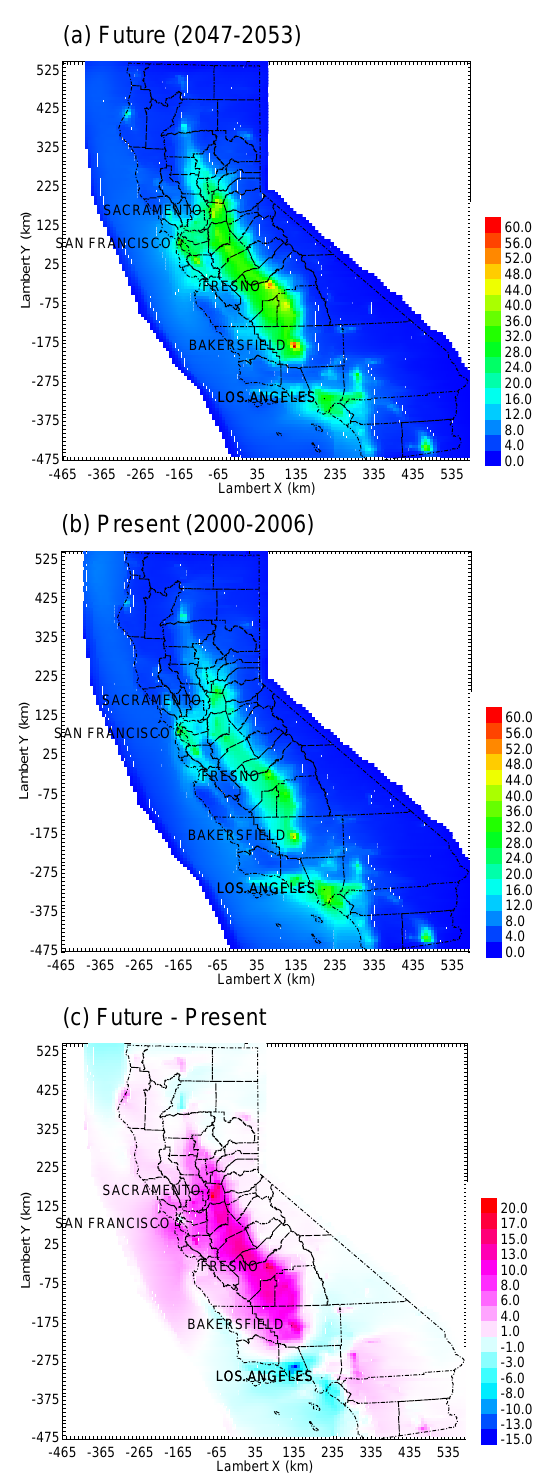
Fig. 4. Average of worst 24-h average PM 2 . 5 total mass concen- trations (µgm − 3 ) corresponding to days with population-weighted concentrations above the 99th percentile values for California un- der the (a) future (2047–2053), and (b) present-day climate (2000– 2006) conditions. (c) shows the difference between the future (a) and present-day (b)